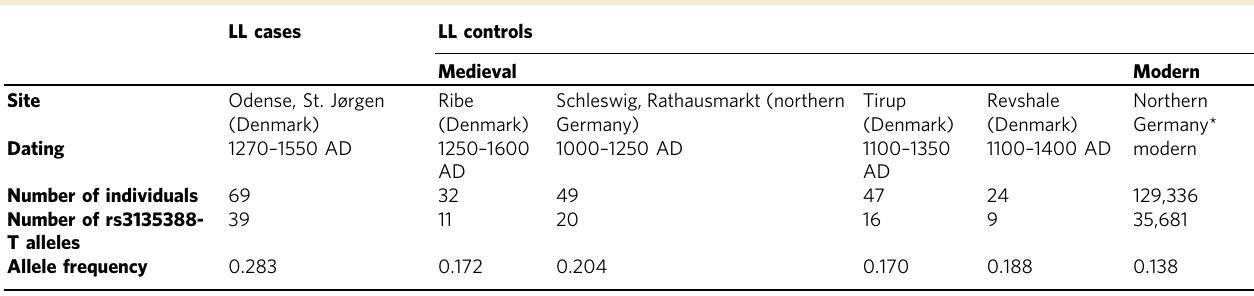
Table 1 Frequency of the rs3135388-T